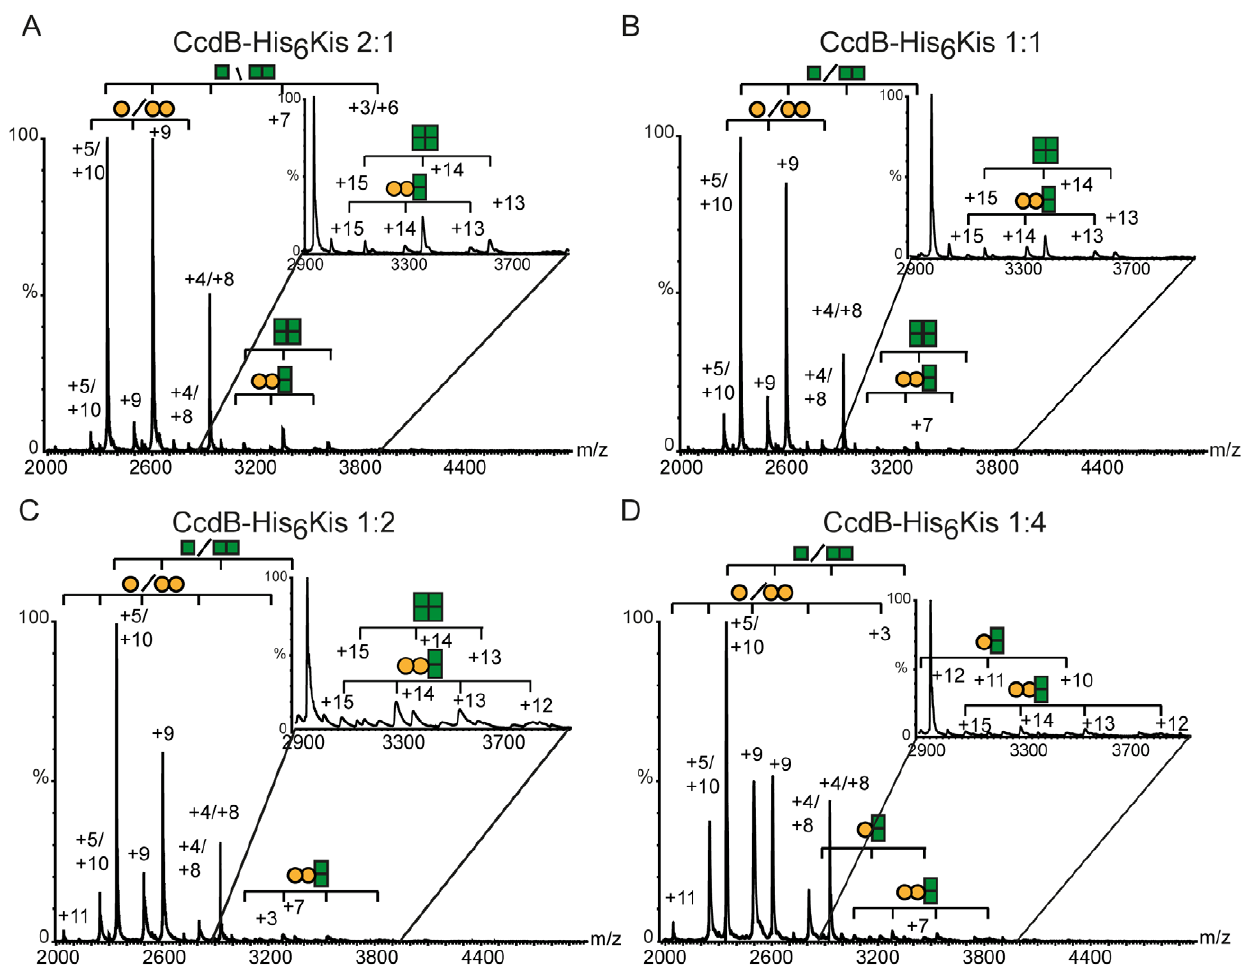
Figure 6. NMS profile of the interactions of CcdB and His 6 Kis proteins at different toxin-antitoxin ratios. (A) Mass spectrum obtained at a CcdB:His 6 Kis molar ratio of 2:1. (B) Mass spectrum obtained at a CcdB:His 6 Kis molar ratio of 1:1. (C) Mass spectrum otained at a CcdB:His 6 Kis molar ratio of 1:2. (D) Mass spectrum obtained at a CcdB:His 6 Kis molar ratio of 1:4. All the protein mixtures were performed in 100 mM ammonium acetate pH 6.7. The lowest protein concentration was 10 m M in all cases except the 1:4 ratio that was 5 m M. CcdB protein is represented with green squares and His 6 Kis with yellow circles. Each complex found is represented with the appropriate combination of squares and circles.